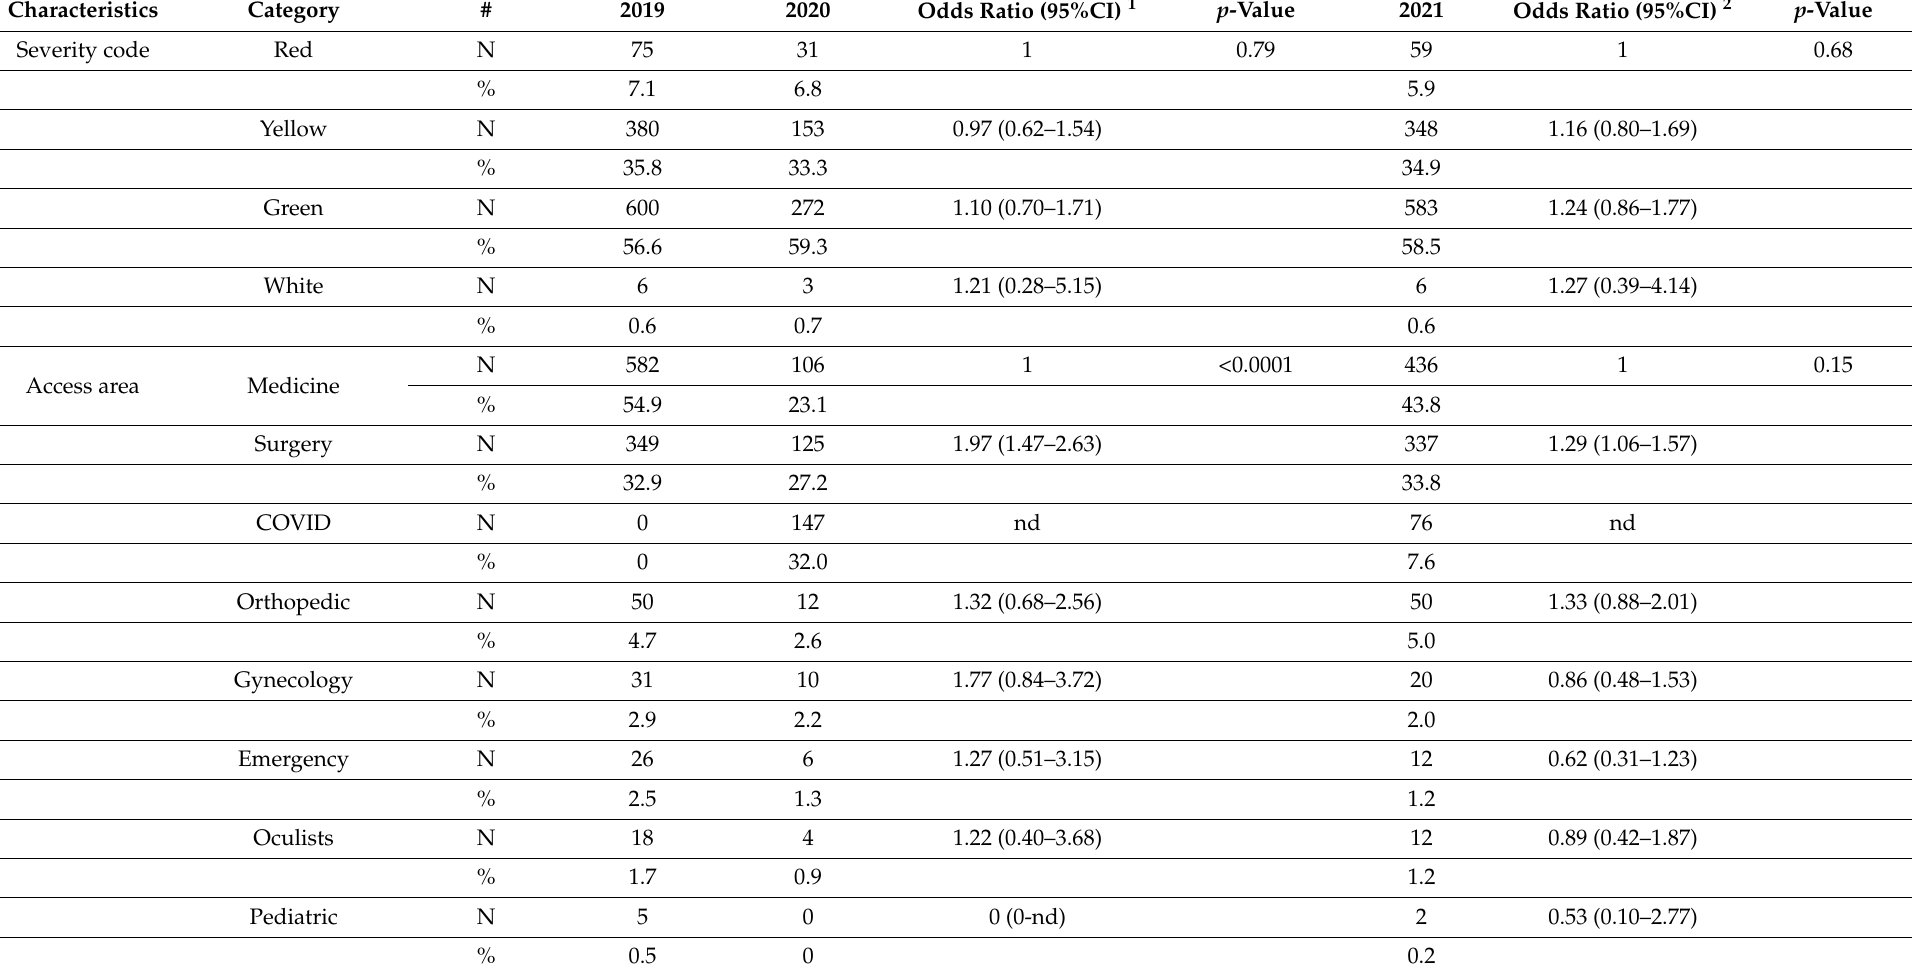
Table 3. Characteristics of ED oncological